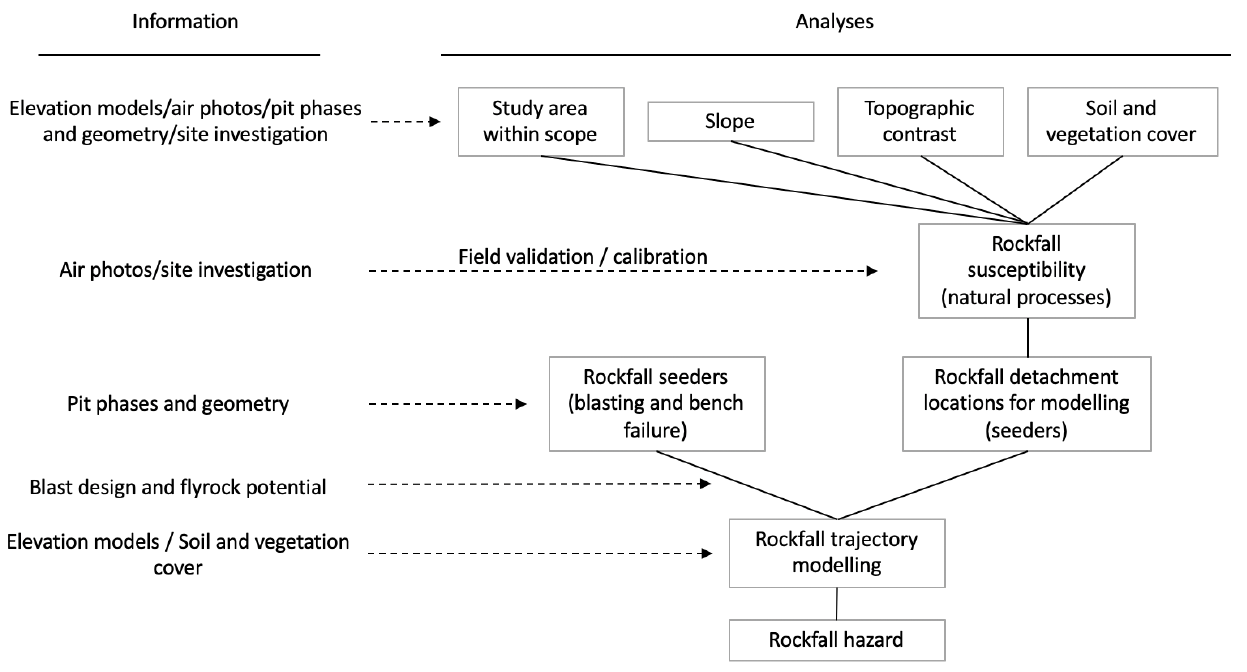
Figure 2. Work flow of the proposed rockfall hazard assessment method.